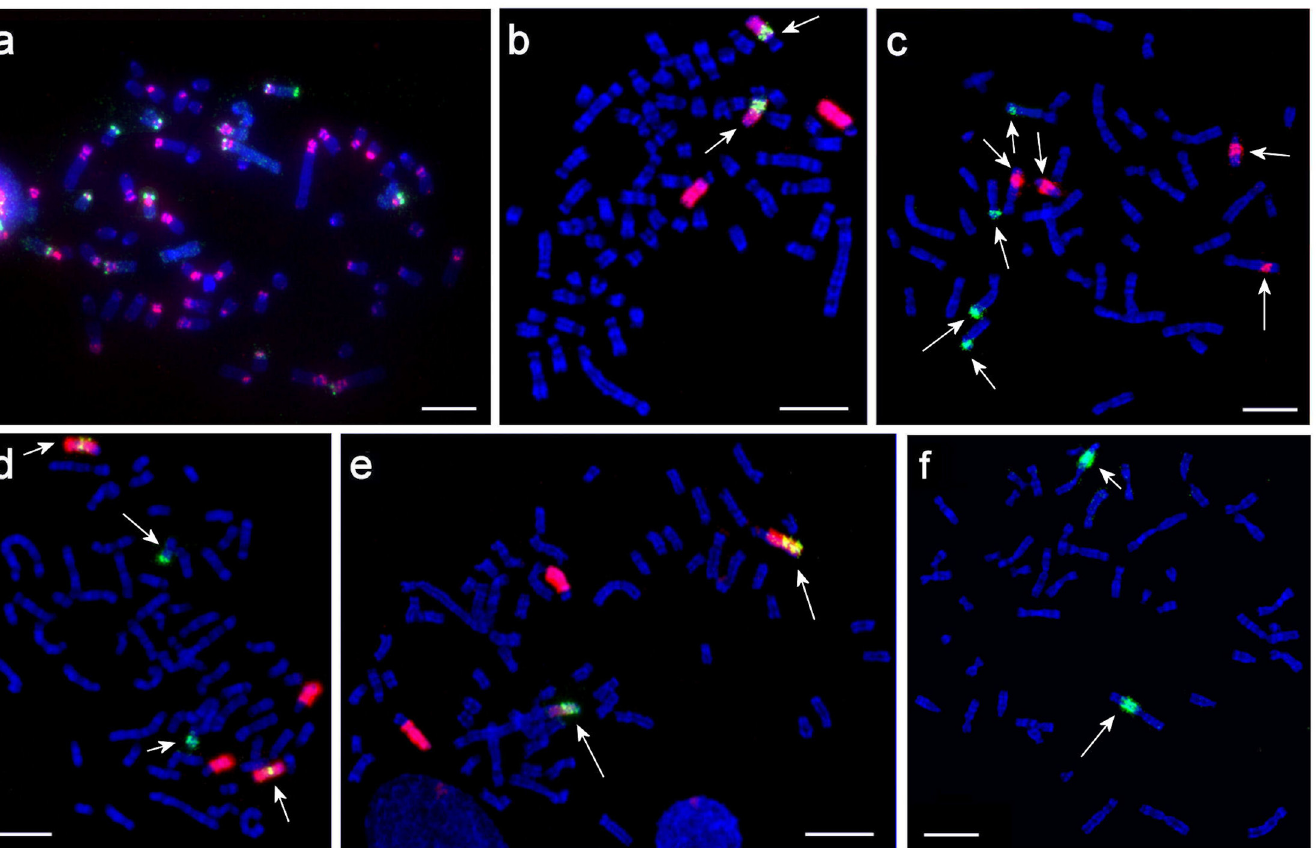
Fig 4. Examples of fluorescent in situ hybridization. a — localization of telomeric DNA probe (red) and rDNA probe (green) on metaphase chromosomes from C . porcellus ; telomeric signals are too weak to capture without risking over-exposure to the strong signals from pericentromeric regions; b — HSA19 (green) and CPO6+7 (red) on metaphase chromosome from C . porcellus ; c — CPO26 (green) and CPO19 (red) on metaphase chromosome from H . sapiens ; d — HSA22 (green) and CPO14+16 (red) on metaphase chromosomes from C . porcellus ; e — HSA20 (green) and CPO6+7 (red) on metaphase chromosomes chromosome from C . porcellus ; f — CPO14 on metaphase chromosomes from H . sapiens . Arrows indicate the corresponding human chromosomes in 4b, 4d, 4e and the corresponding C . porcellus chromosomes in 4c and 4f. Scale bars indicate 10 μ m.